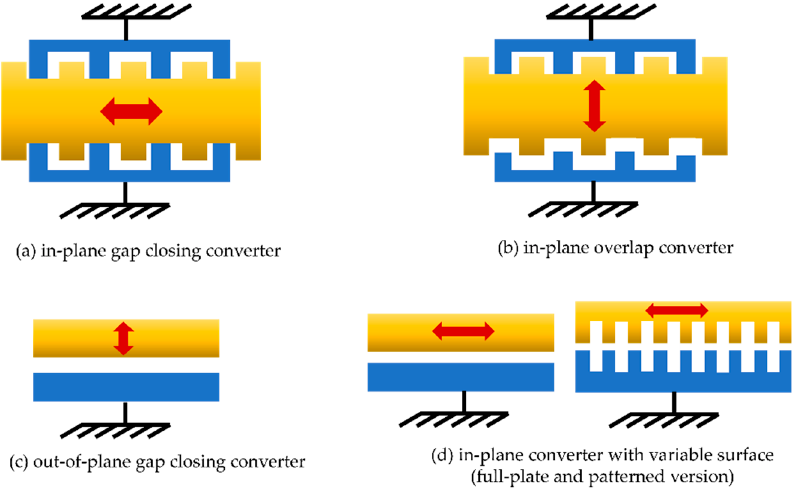
Figure 10. Main shapes of electrostatic generators: ( a ) in-plane gap closing converter, ( b ) in-plane overlap converter, ( c ) out-of-plane gap closing converter, ( d ) in-plane converter with variable sur- face [95].